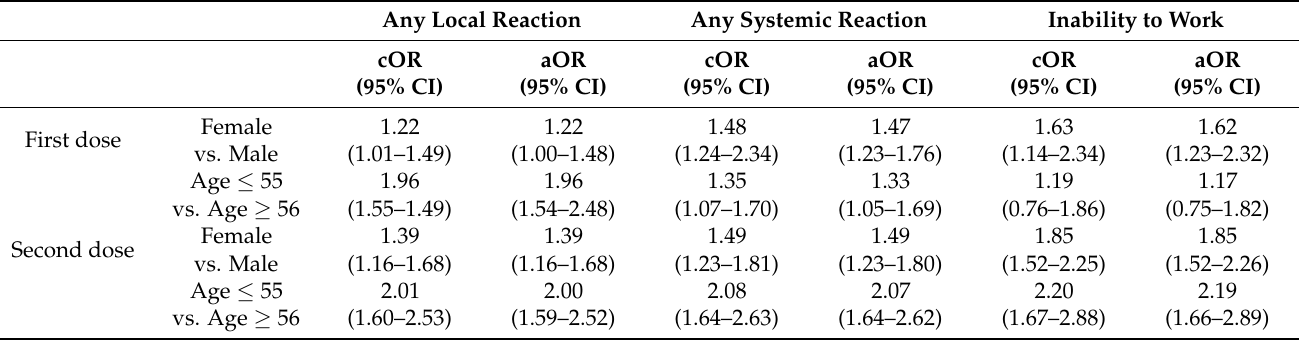
Table 3. Bivariate analysis for factors associated with higher risk for adverse effects given in crude odds ratio (cOR) and adjusted odds ratio (aOR) after first and second dose of BNT162b2 mRNA